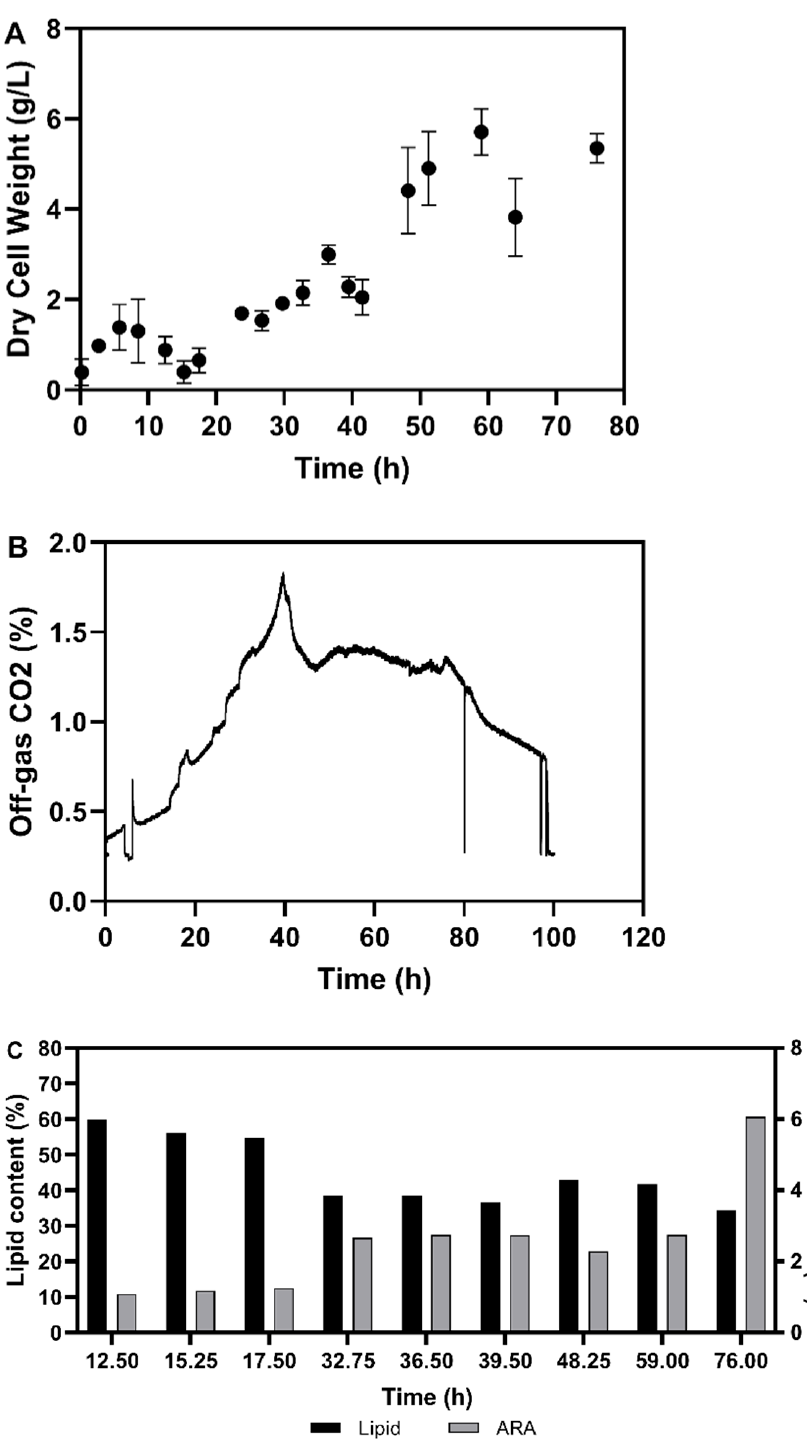
Figure 6. ( A ) Dry cell weight (DCW), ( B ) off-gas CO 2 profile, ( C ) total lipid content (% wt of dry cell weight) and arachidonic acid (ARA) content (% wt of total lipid weight) obtained during the batch cultivation of M. alpina in fermenter using animal fat rest